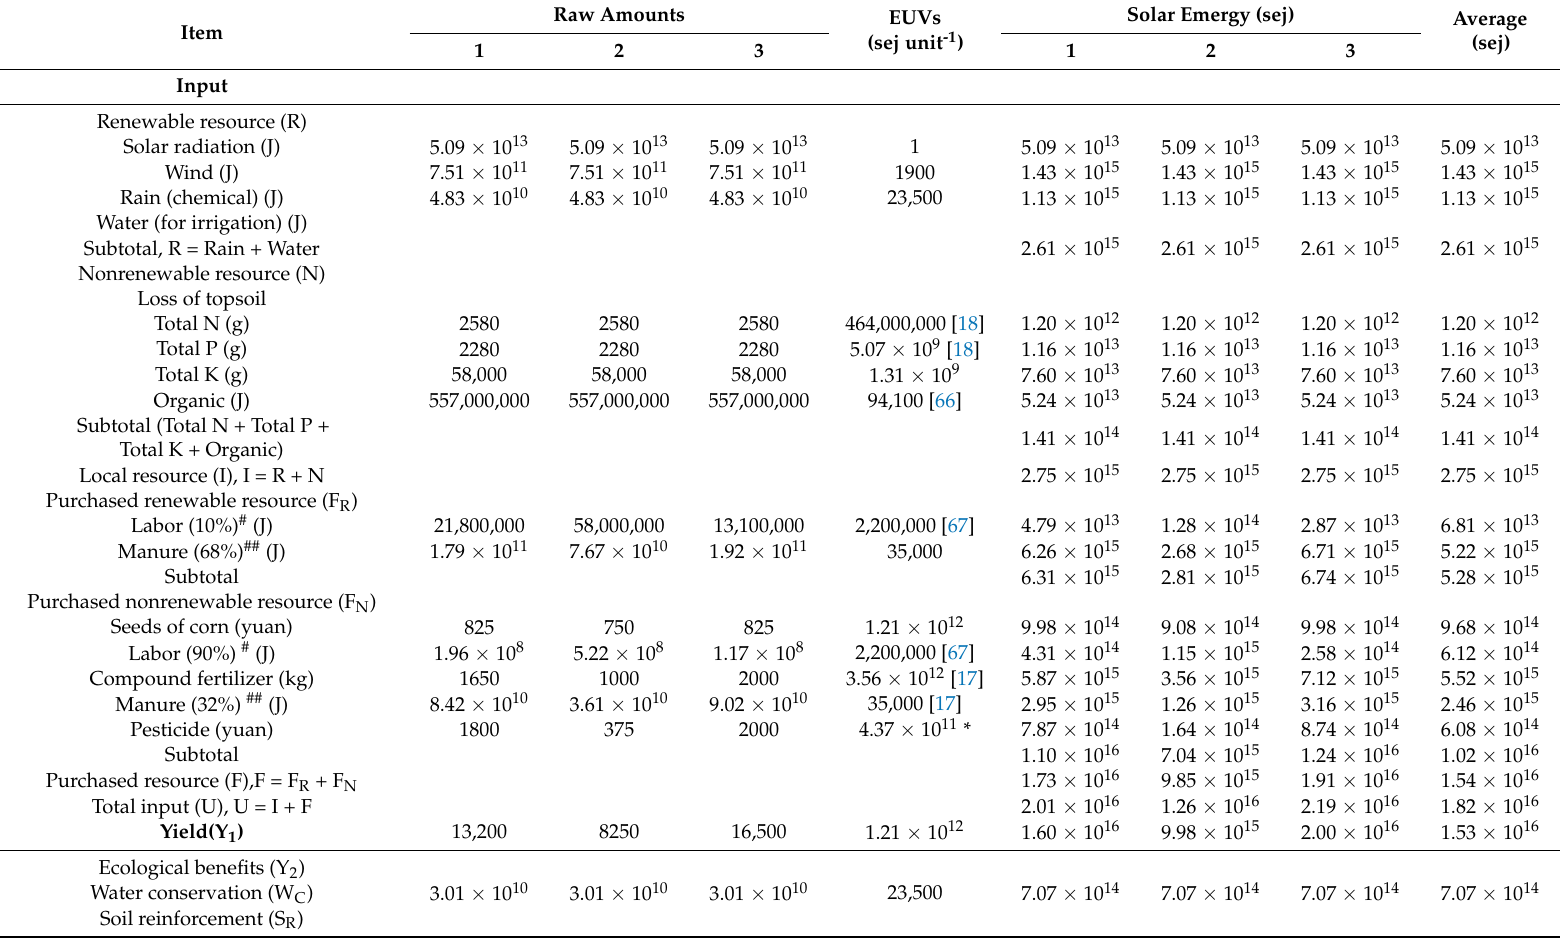
Table A1. Emergy analysis table of the CP in